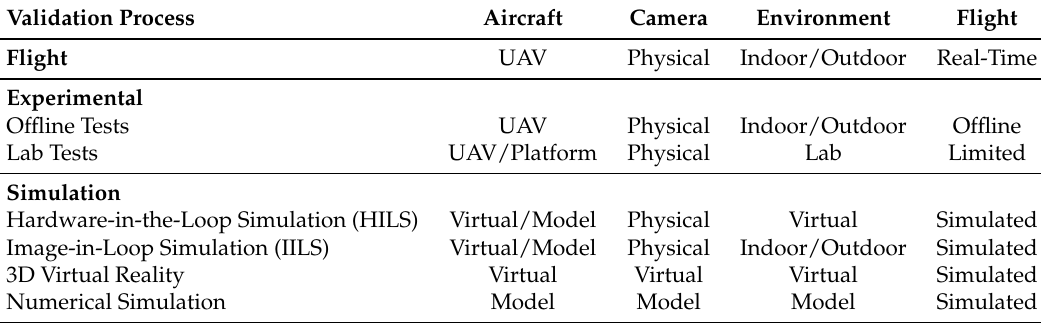
Table 2. Validation process. Features of the trials.